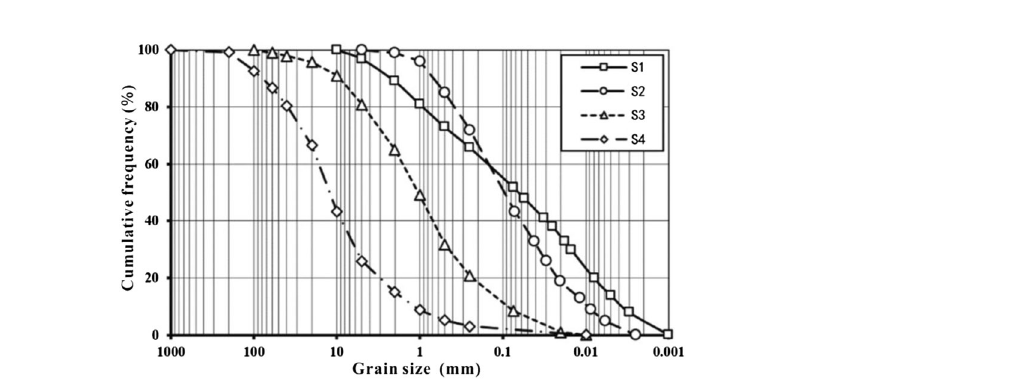
Figure 3. Grain-size distribution curves of the samples.